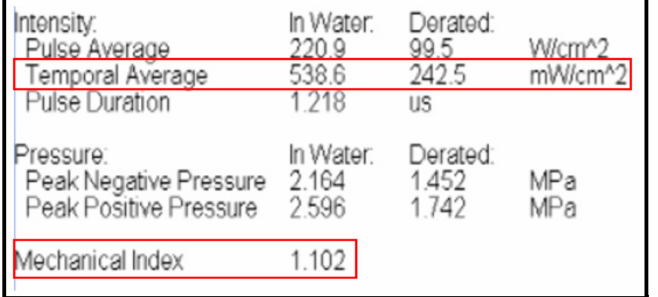
Figure 1. I SPTA.a and MI values.